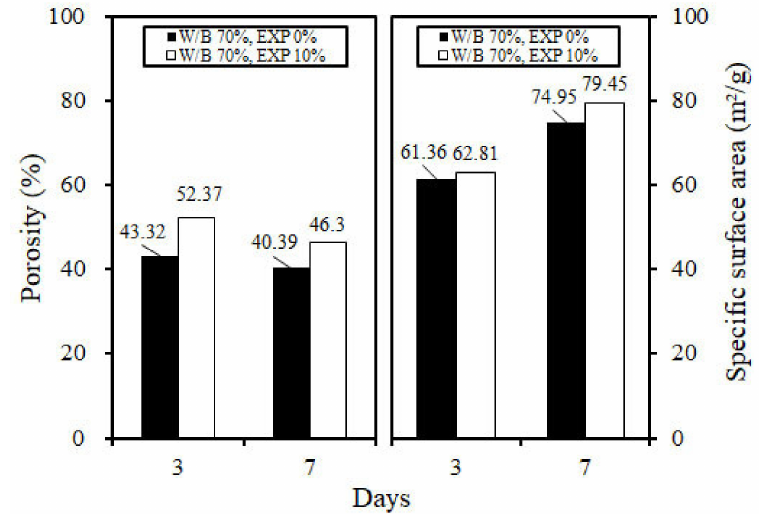
Figure 6. Porosity and total pore area.